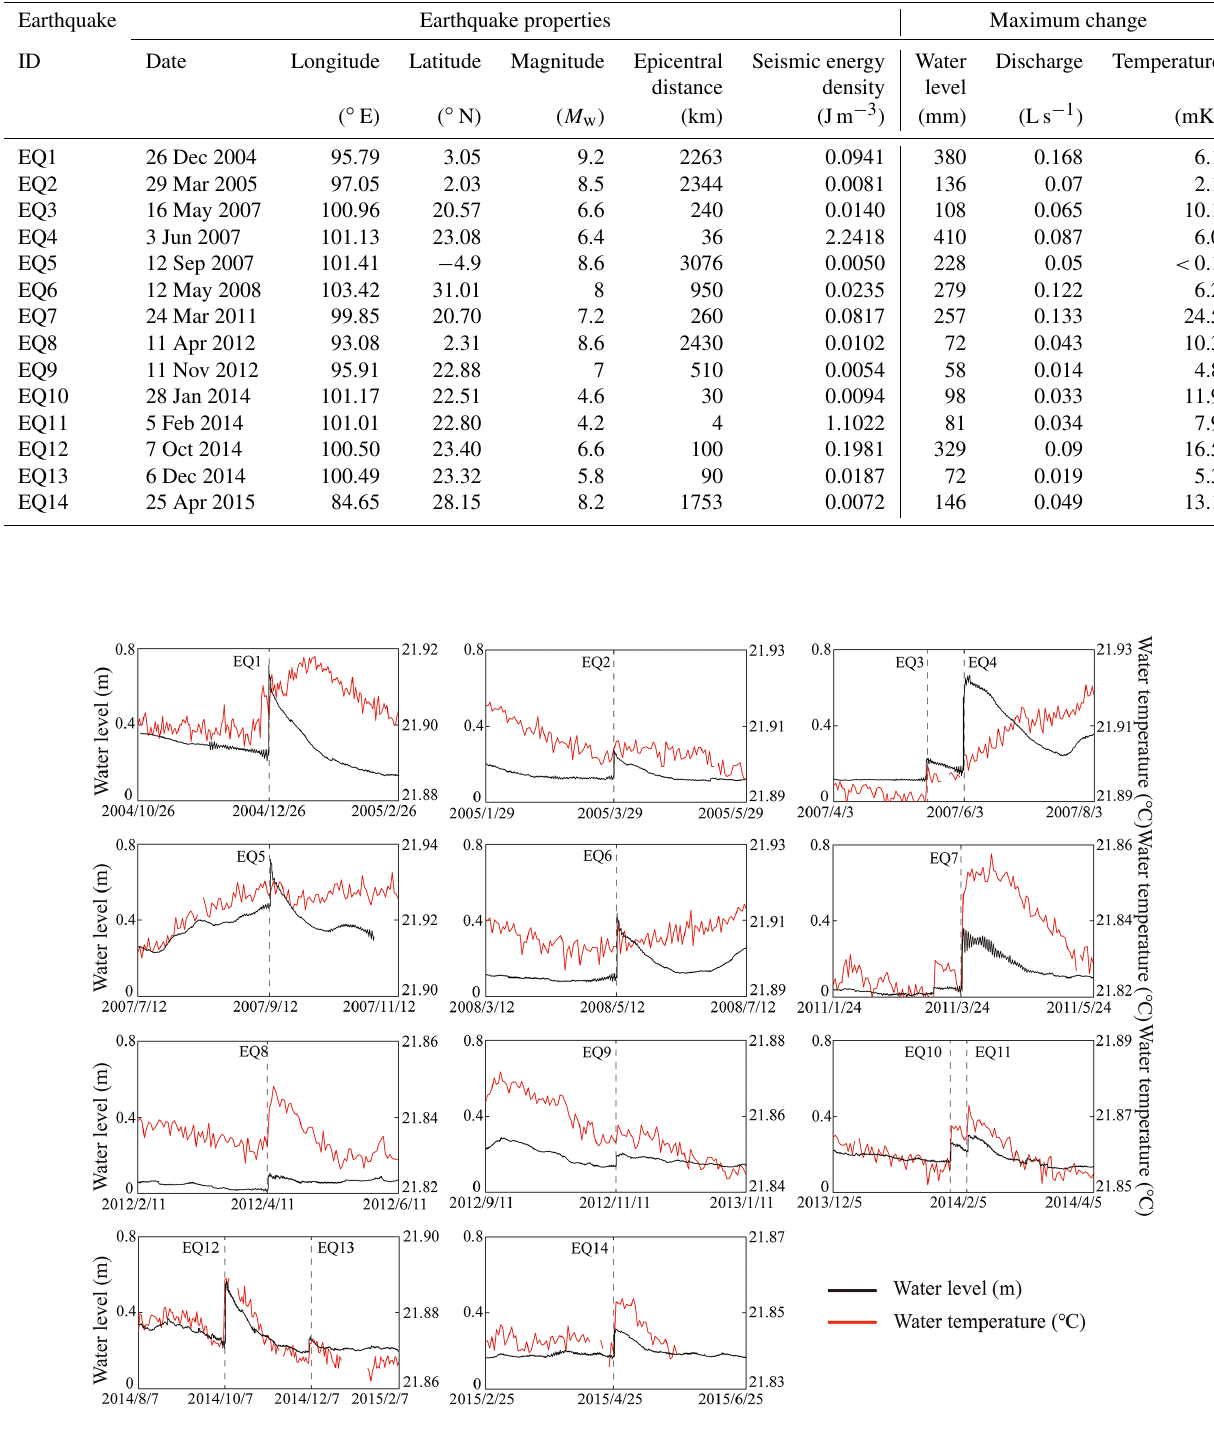
Figure 3. Water-level and temperature changes induced by 14 earthquakes in Dazhai well, western Yunnan Province, China. The water-level changes have been corrected for Earth tide. Vertical dashed lines indicate earthquake